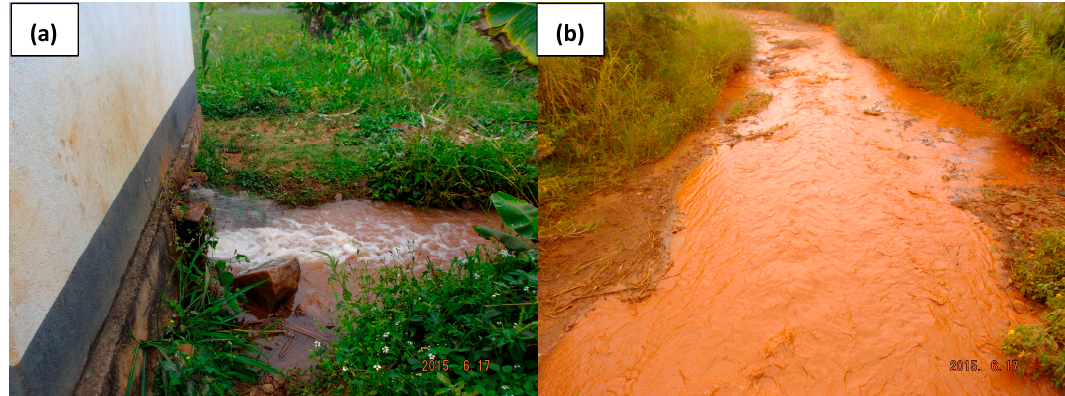
Figure 9. ( a ) Outside of the powerhouse for one of the area’s hybrid generator for electricity and grain milling with return flow to the river. ( b ) Example of sediment transported by the river water as a result of upstream deforestation and artisanal gold mining (photo by Miguel M. Uamusse).